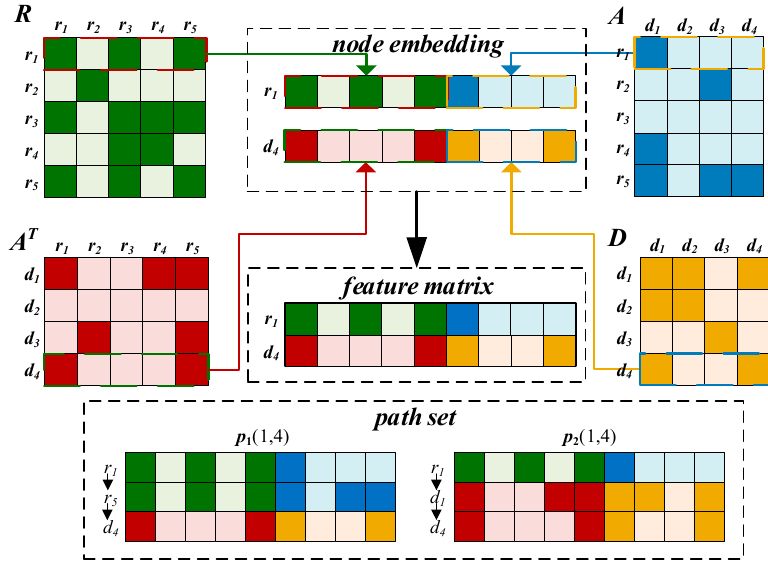
Figure 3. Integration process of drug and disease nodes to construct the feature matrix in the CNN module of our model and path set in the BiLSTM module of our model.